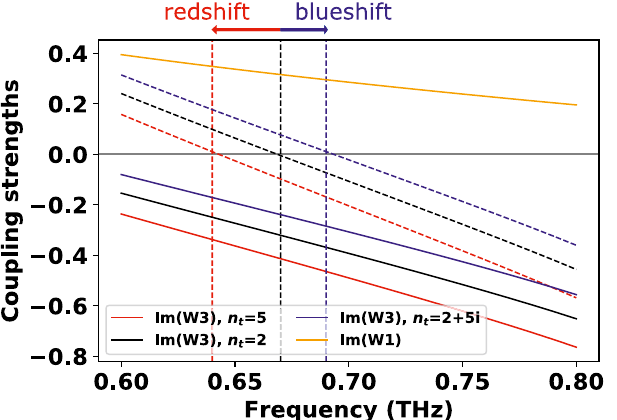
Figure 5. Plots of coupling strengths Im ( W 1 ) (orange solid line), Im ( W 3 ) (black, red, blue solid lines), and Im ( W 1 + W 3 ) (black, red, blue dotted lines) for different refractive indices of thin film ( n t ). The black, red, and blue colors represent n t = 2 , n t = 5 , and n t = 2 + 5 i , respectively. The resonance transmission positions (black, red, blue vertical dotted lines) occur around the zero-crossing points of each dotted line ( Im ( W 1 + W 3 ) ).